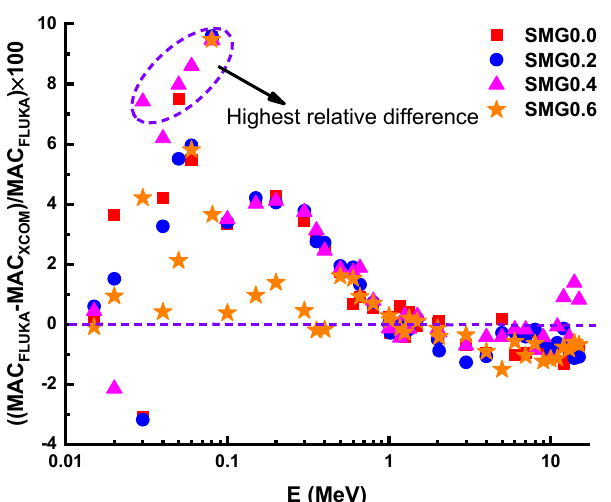
Nanomaterials 2021 , 11 , x FOR PEER REVIEW Figure 11. The relative difference of mass attenuation coefficient by XCOM and FLUKA simulation.